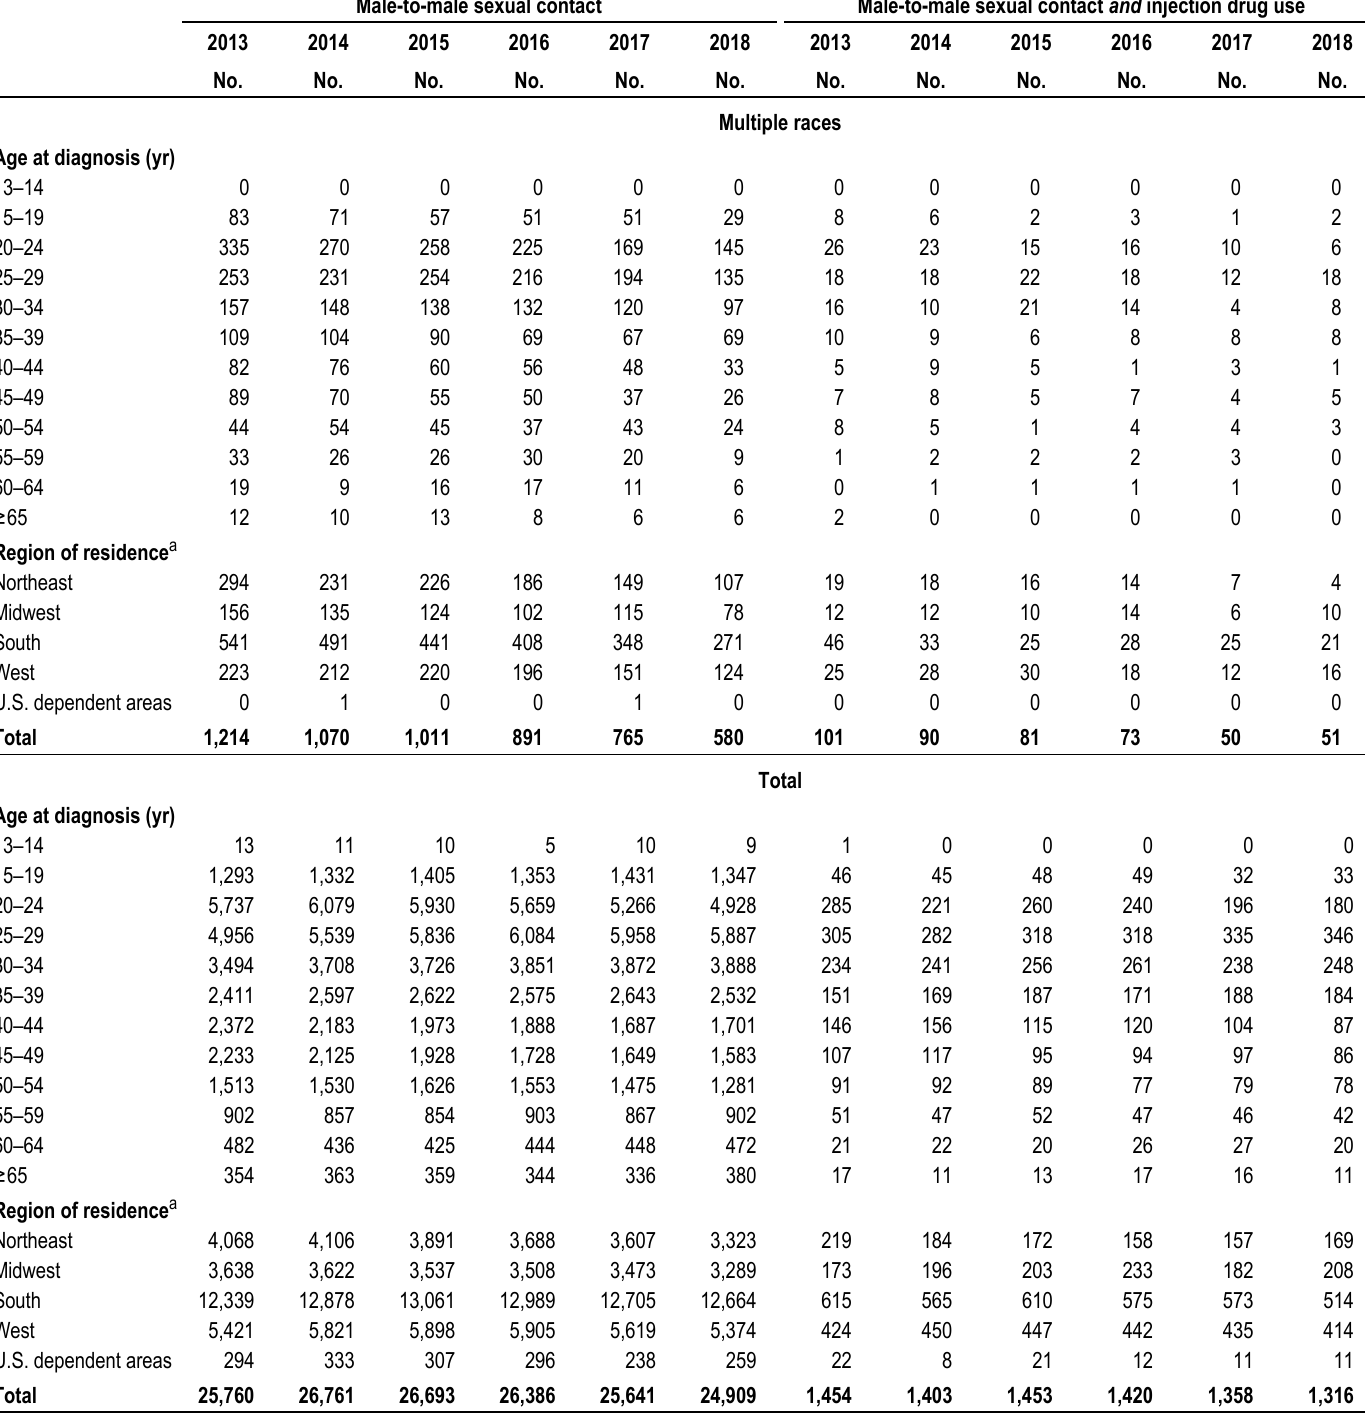
Table 7b. Diagnoses of HIV infection attributed to male-to-male sexual contact and male-to-male sexual contact and injection drug use, by selected characteristics, 2013–2018—United States and 6 dependent areas (cont) Male-to-male sexual contact Male-to-male sexual contact and injection drug